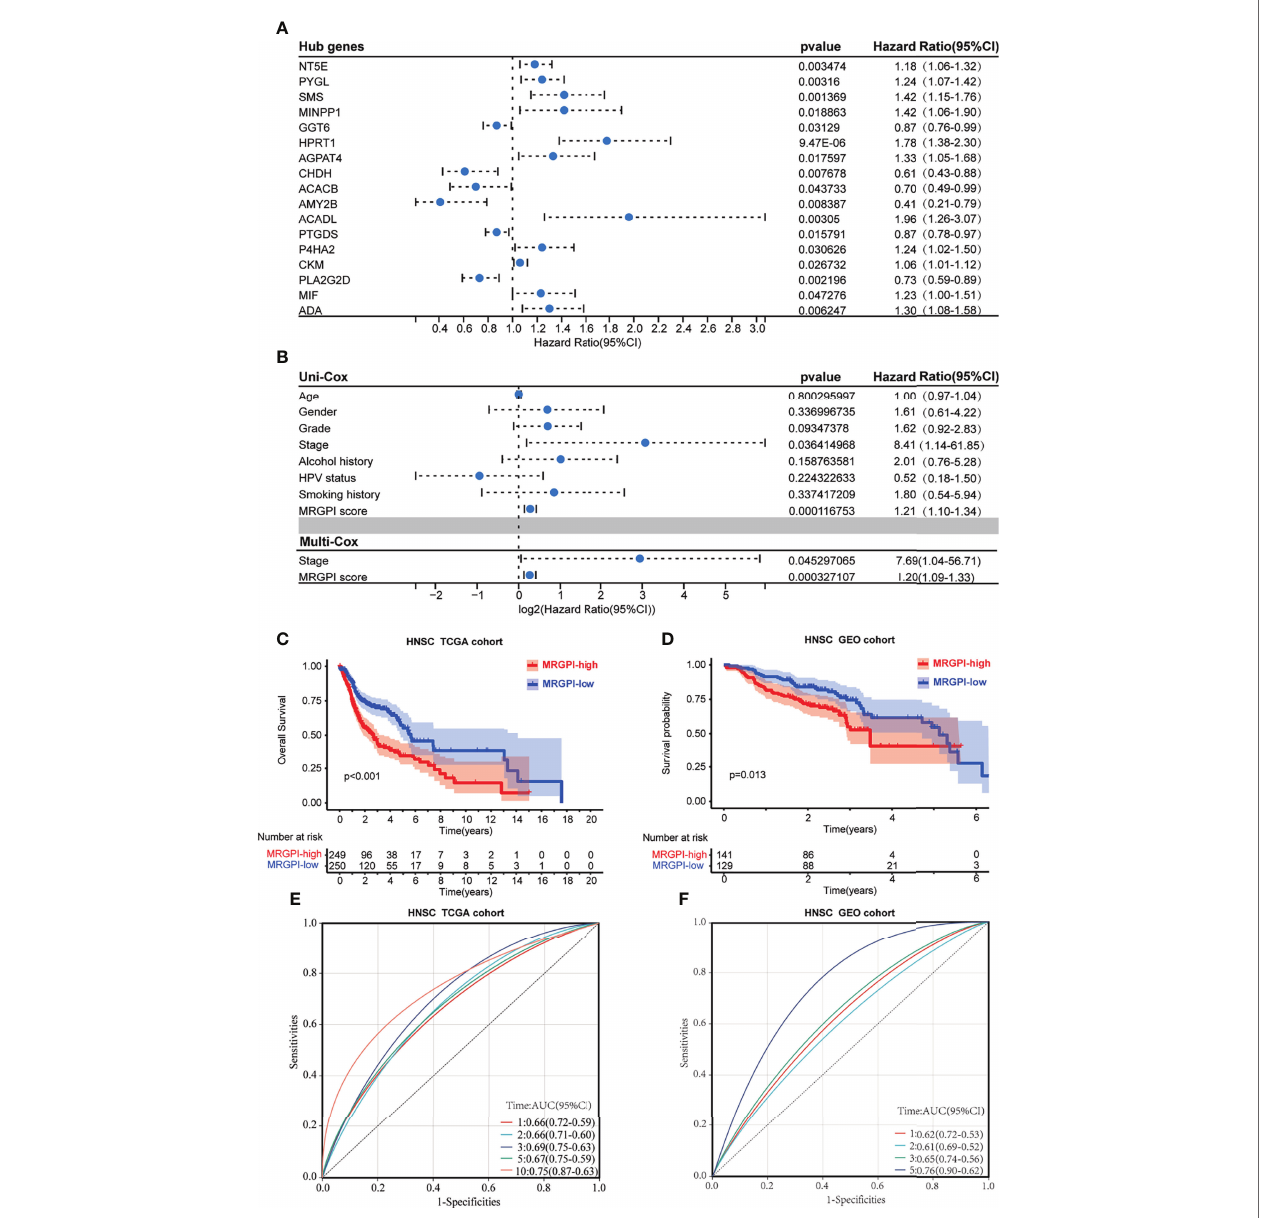
FIGURE 1 | The prognostic role of the MRGPI. (A) Univariate Cox analysis of 17 metabolism-related hub genes. (B) Univariate Cox analysis of clinicopathologic factors and the MRGPI score and multivariate Cox analysis of the factors signi fi cant in the univariate Cox analysis (p < 0.05). (C) Kaplan – Meier analysis of the MRGPI subgroups in TCGA cohort. (D) Kaplan – Meier analysis of the MRGPI subgroups in the GEO cohort. (E) ROC analysis of the MRGPI on OS at 1-, 2-, 3-, 5-, and 10- year follow-up in TCGA cohort. (F) ROC analysis of the MRGPI on OS at 1-, 2-, 3-, and 5-year follow-up in the GEO cohort. MRGPI, metabolism-related gene prognostic index; TCGA, The Cancer Genome Atlas; GEO, Gene Expression Omnibus; ROC, Receiver operating characteristic